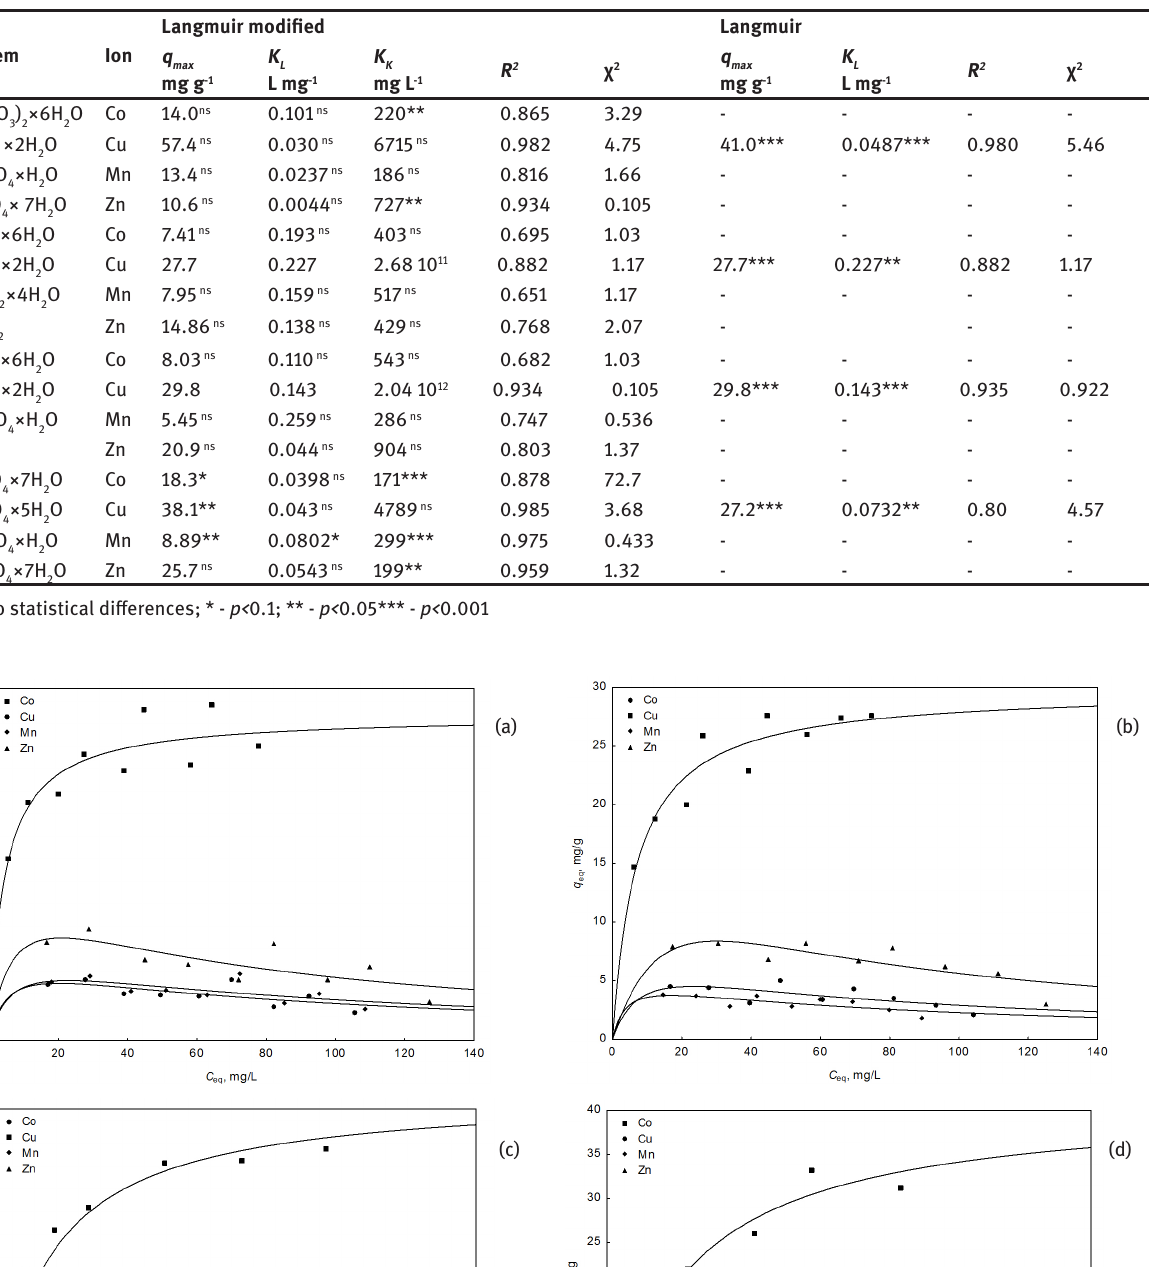
Table 2: The parameters of the Langmuir modified model that describe the biosorption of microelements in a muli-cation system with the competition as well as parameters of the traditional Langmuir model